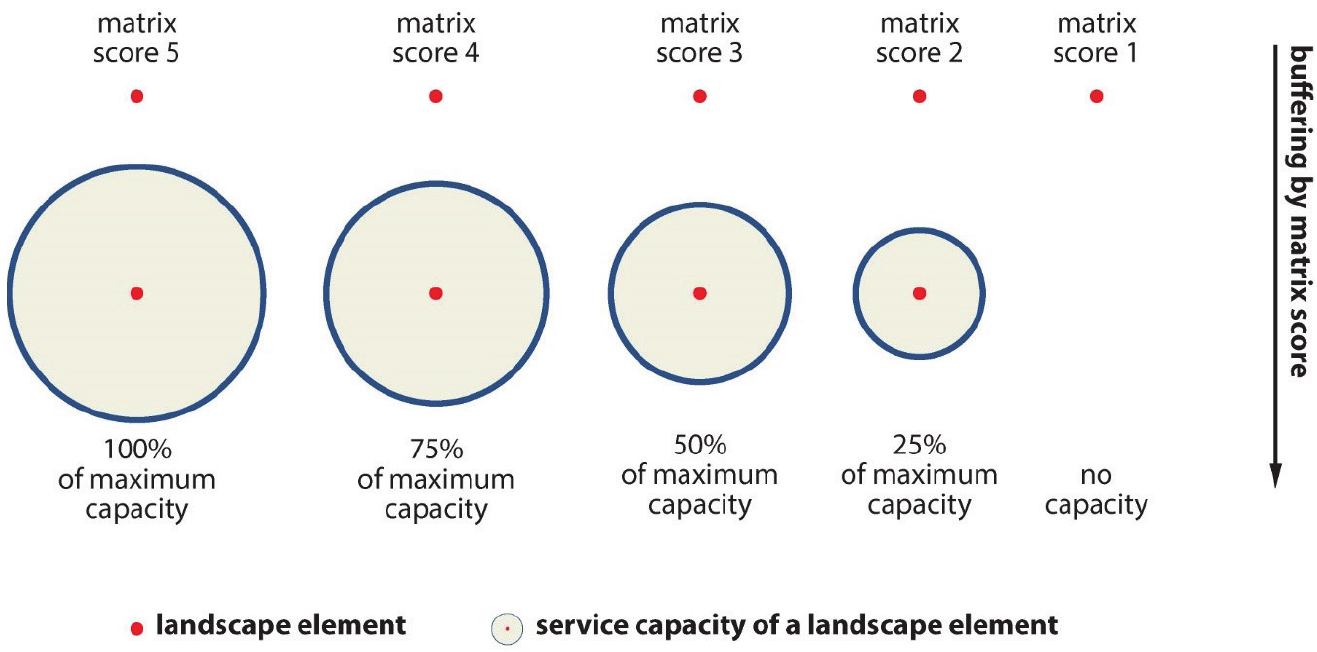
Figure 4 Graph exemplifying the theoretical assumption for defining the buffer sizes of the landscape service capacity of a landscape